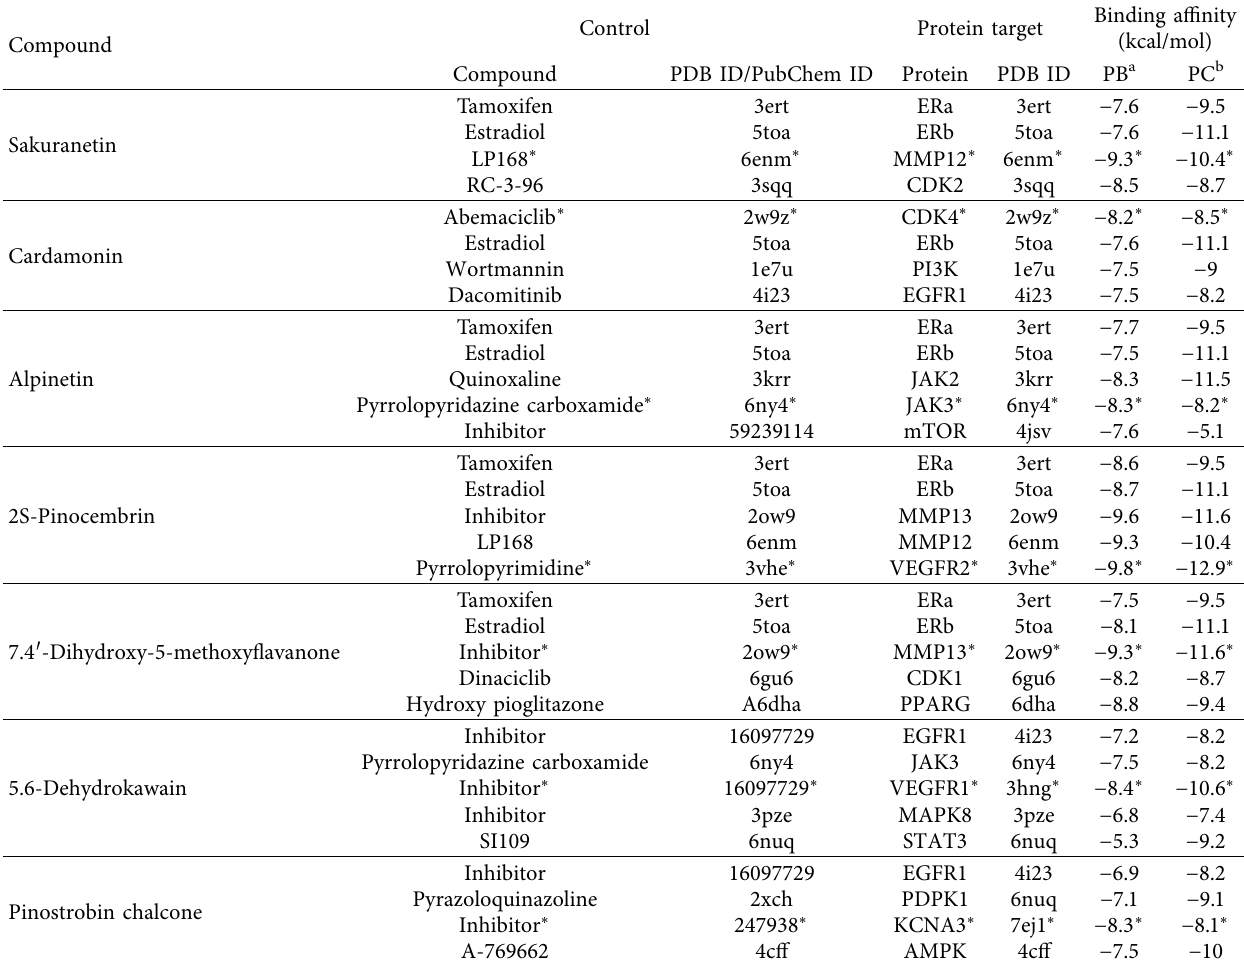
Table 2: Molecular docking simulation